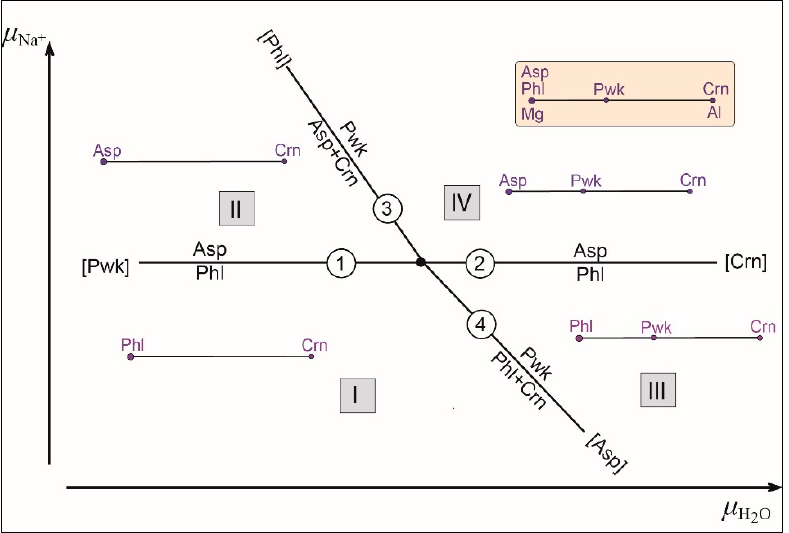
Figure 6. Qualitative 𝜇 (cid:2898)(cid:2911) (cid:3126) − 𝜇 H 2 O diagram of mica parageneses in the system Na-Mg-Al-Si-CO 2 -H 2 O. I, II, III, IV—stable divariant fields; the numbers in circles indicate the reaction numbers in